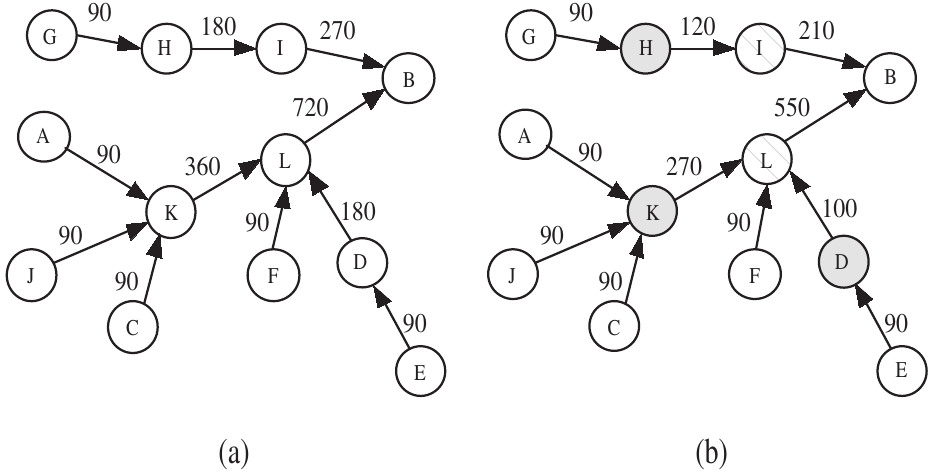
Figure 1. Impact of upstream-node effect on false positive rate: ( a ) normal sending rate, ( b ) sending rate under packet dropping